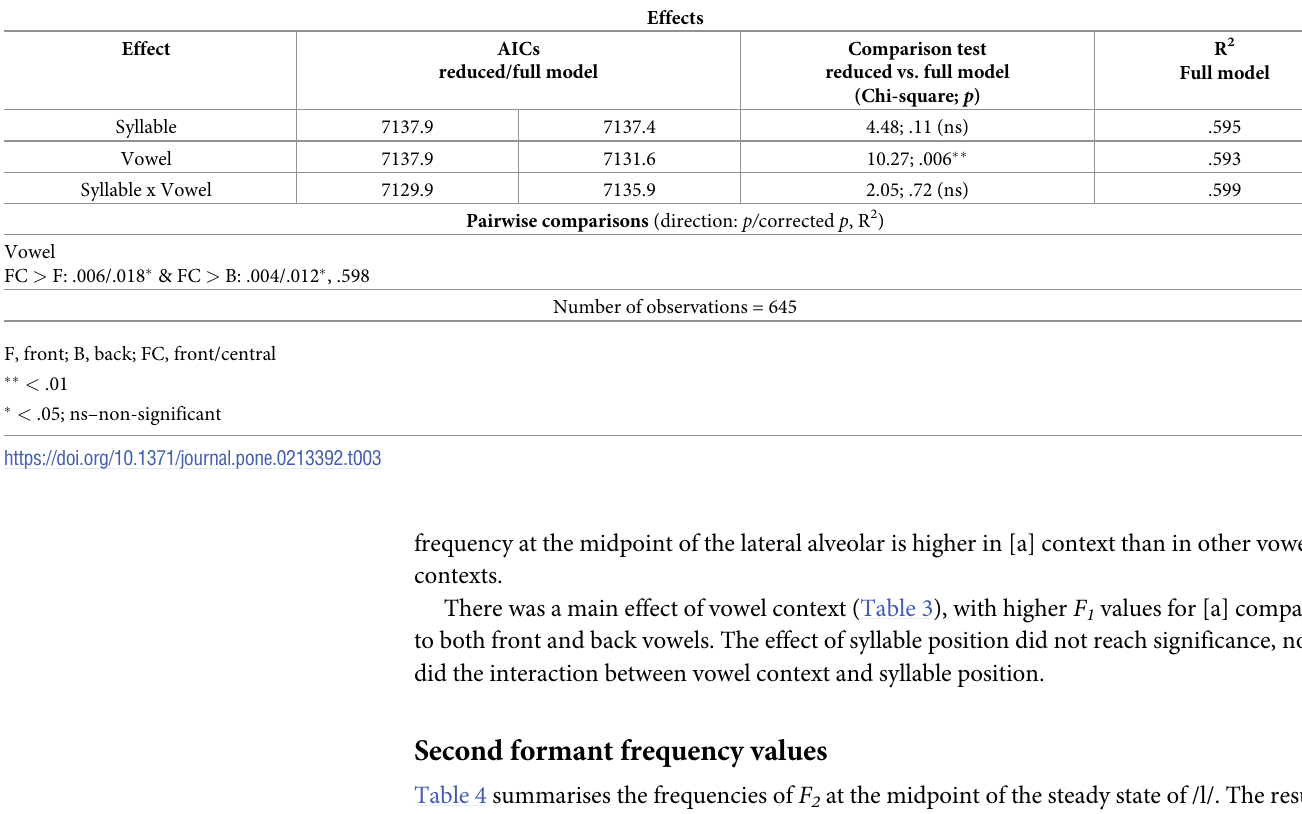
Table 4. Descriptive statistics for F